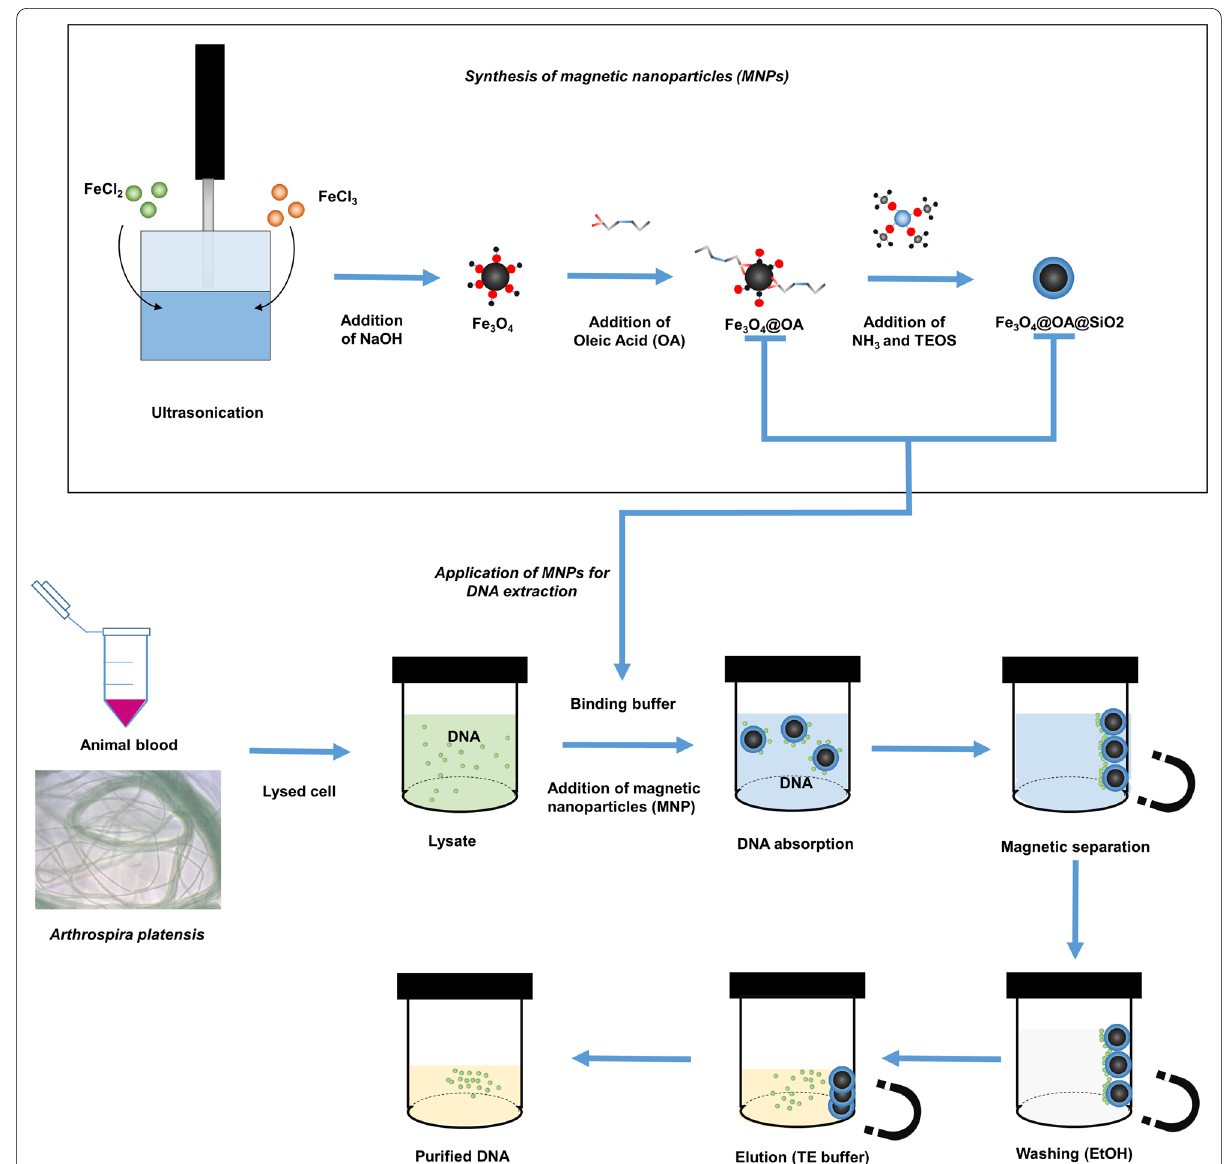
Fig. 1 Schematic study. Oleic acid‑coated magnetic nanoparticles (Fe 3 O 4 @OA) and silica‑coated magnetic nanoparticles (Fe 3 O 4 @OA@SiO 2 ) are prepared. These particles are further applied for the isolation of DNA from Arthrospira platensis and animal